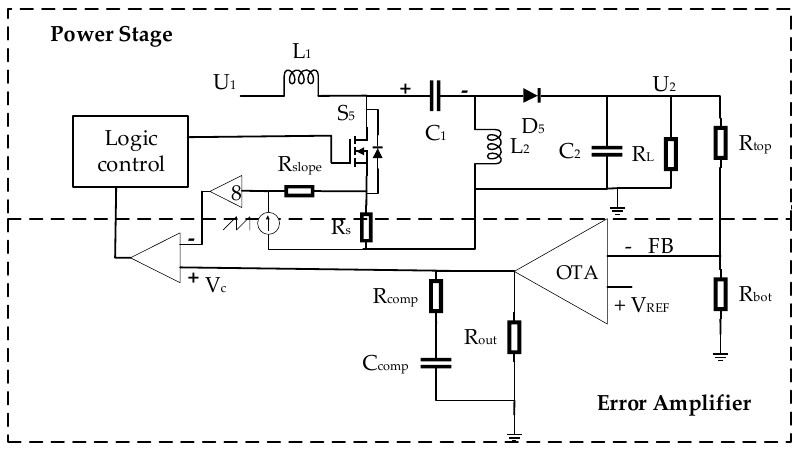
Figure 5. Peak current mode of a dc-dc circuit.